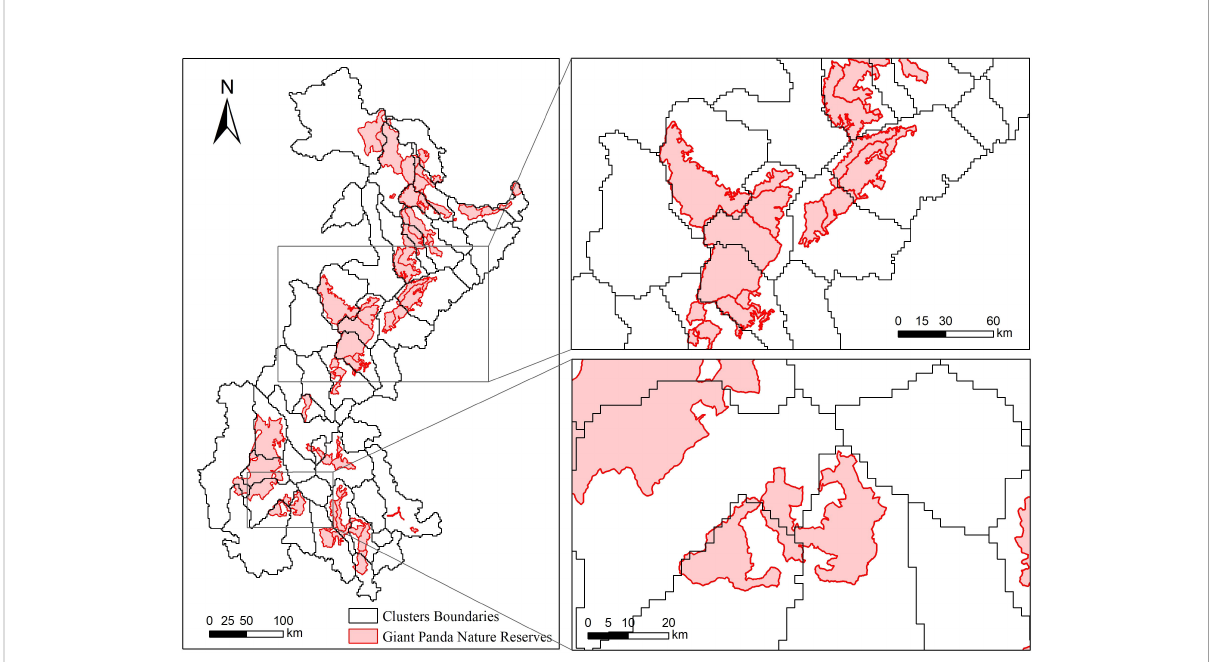
FIGURE 5 The boundaries of giant panda habitat clusters (black polygons) delineated from the Louvain algorithm are shown with the boundaries of the nature reserves (red